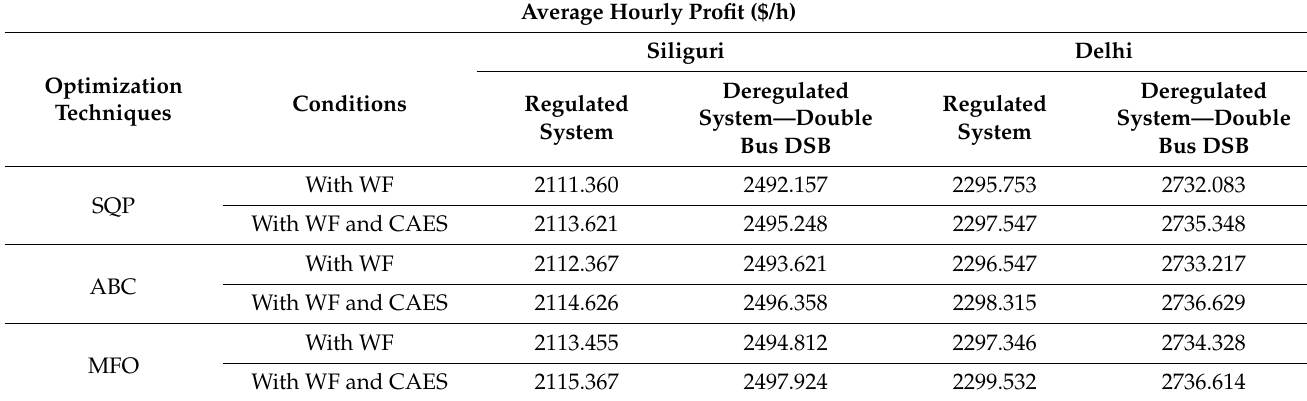
Table 9. Average hourly profit with different optimization techniques for Siliguri and Delhi. Average Hourly Profit ($/h)